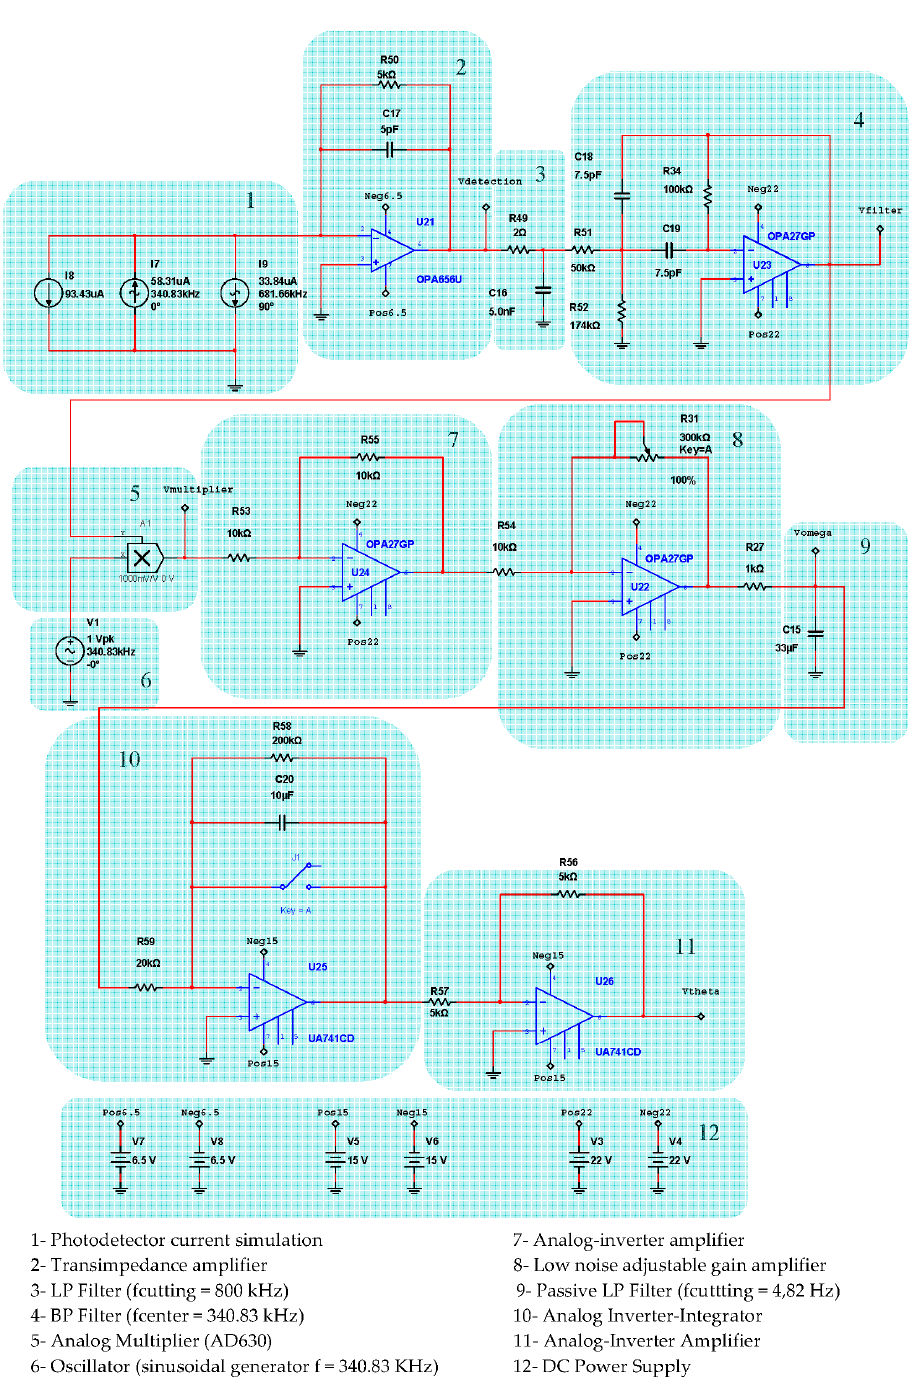
Figure 4. Detection and Phase-Sensitive-Demodulation (PSD) circuits.